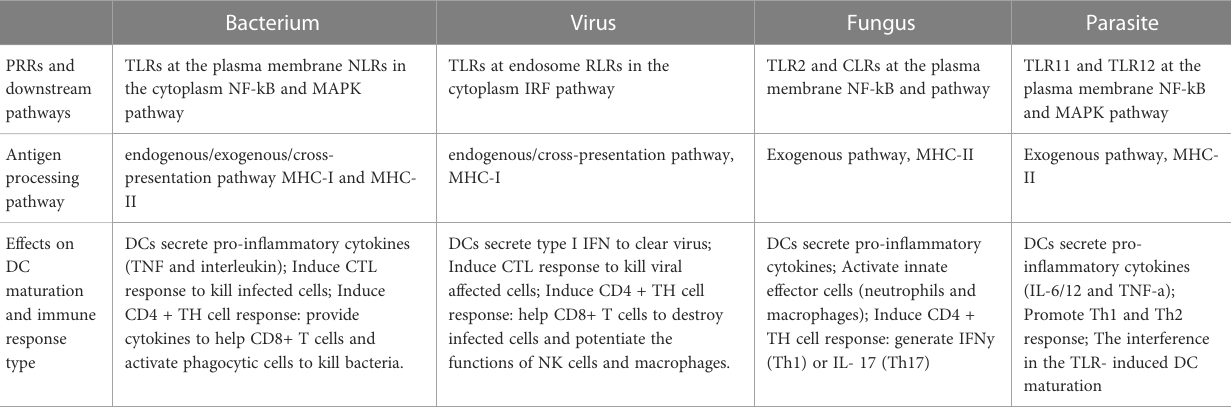
TABLE 2 DC maturation process induced by different